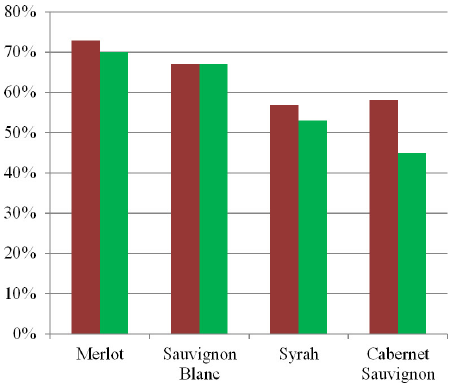
Figure 9. The average PA rates, at the pixel level, for the four most commonly-used varieties in the discriminative classification experiments. Quantitative results on the multispectral (2-m resolution) datasets are given with brown color, while the ones for the pan-sharpened (50-cm resolution) with